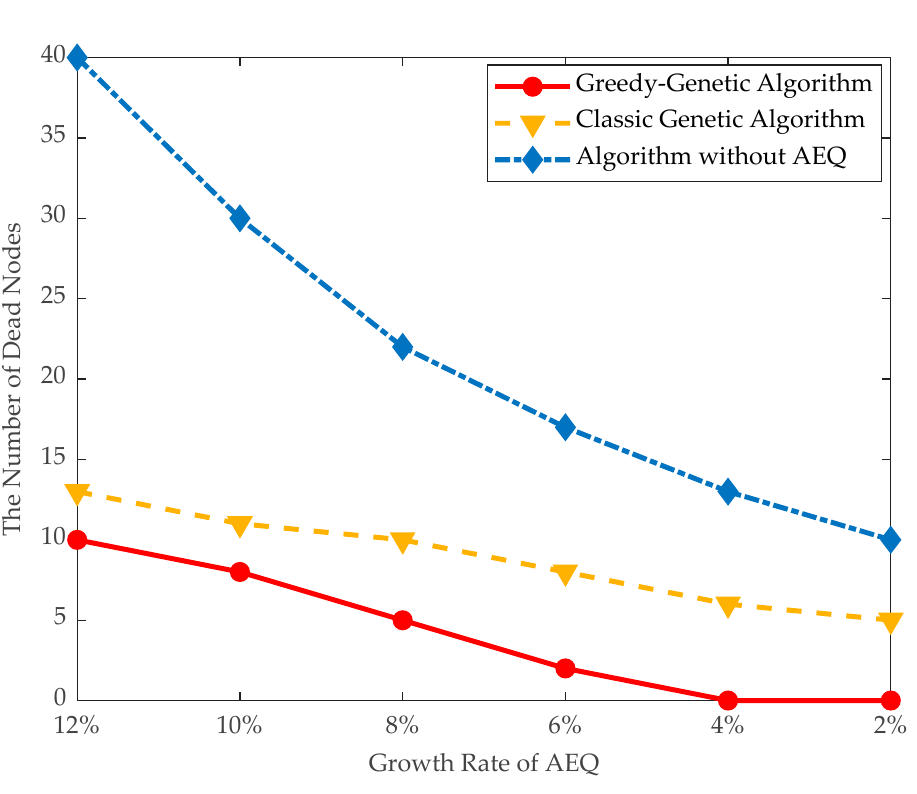
Figure 12. The number of dead nodes.